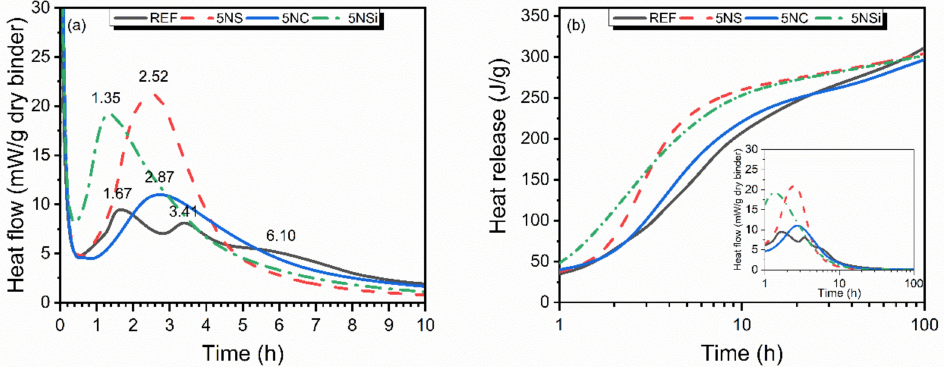
Figure 1. ( a ) Heat flow and ( b ) total heat released and detail of heat flow